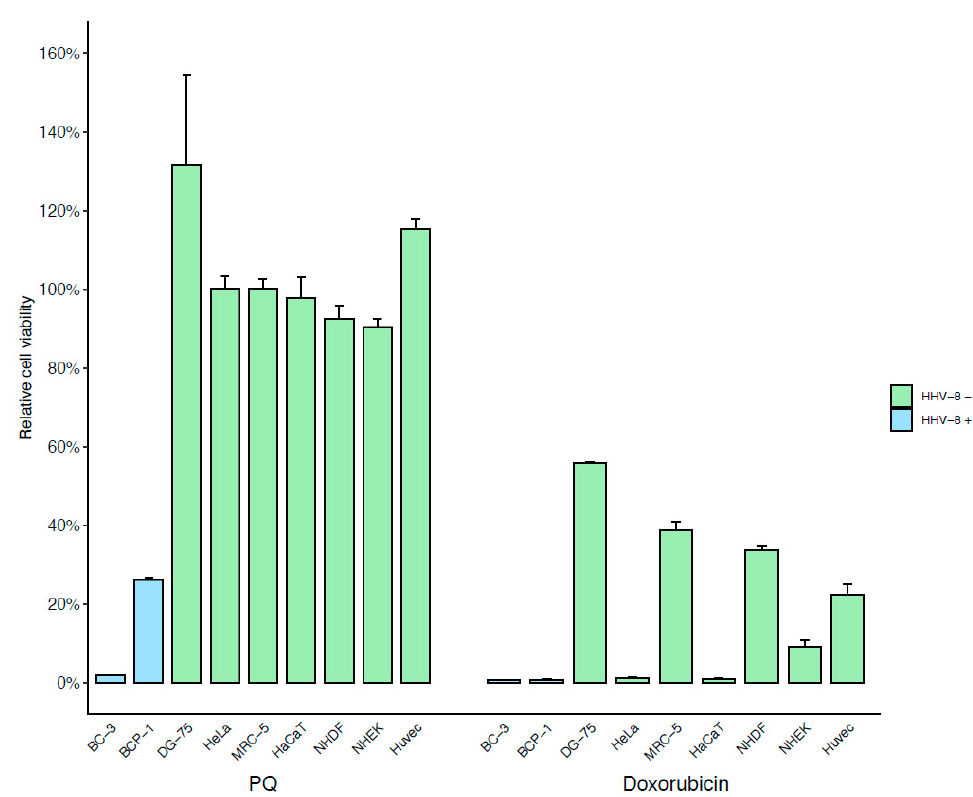
Figure 1. Specific cytotoxic effects of PQ treatment on PEL cell lines. HHV-8-infected PEL cell lines (BC-3, BCP-1) and multiple HHV-8-uninfected cells (DG-75, HeLa, MCR-5, and HaCaT cell lines and primary NHDF, NHEK, and HUVEC cells) were incubated with 10 µ M of PQ or doxorubicin (as control) for 48 h. Cell viability was assessed by CellTiter-Glo 2.0 assay of at least duplicate cultures and expressed as mean relative to their respective untreated control cells. Error bars represent the S.E.M for at least two independent experiments.